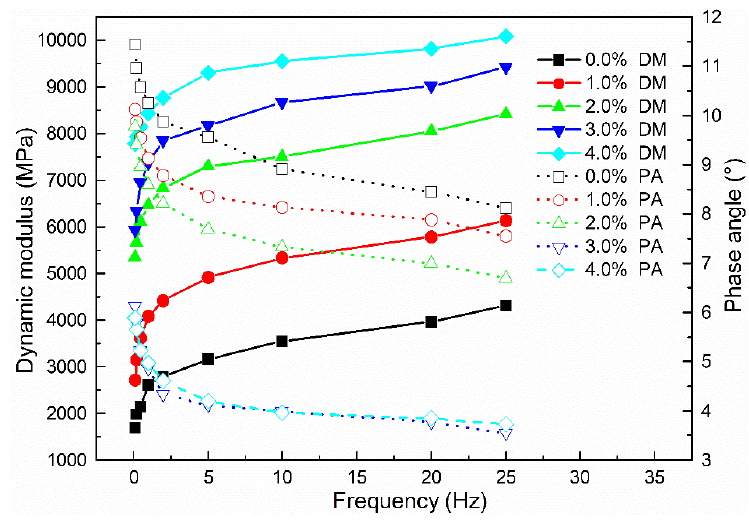
Figure 15. Influence of cement content on mechanical properties of CRAM.